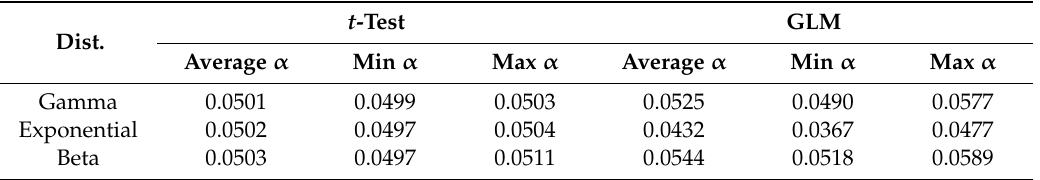
Table 2. Summary of Type I error rates for gamma, exponential and beta distributed data tested using the t -test and